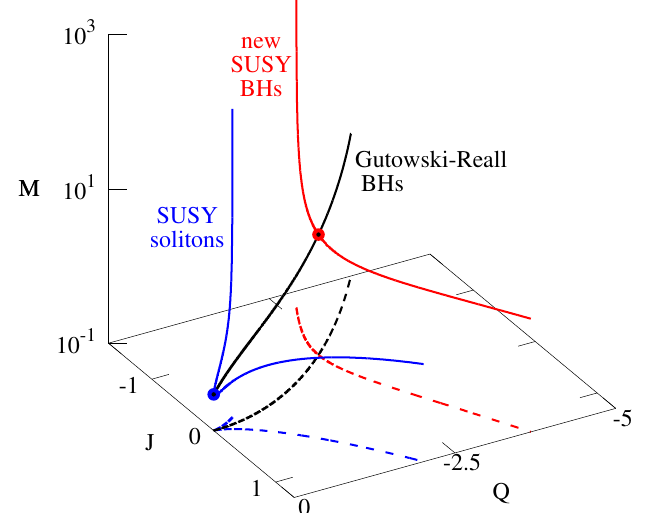
Figure 1. The mass-angular momentum-electric charge diagram is shown for the supersymmetric solitons in [19], the Gutowski-Reall BHs [10] and the new supersymmetric BHs in this work.